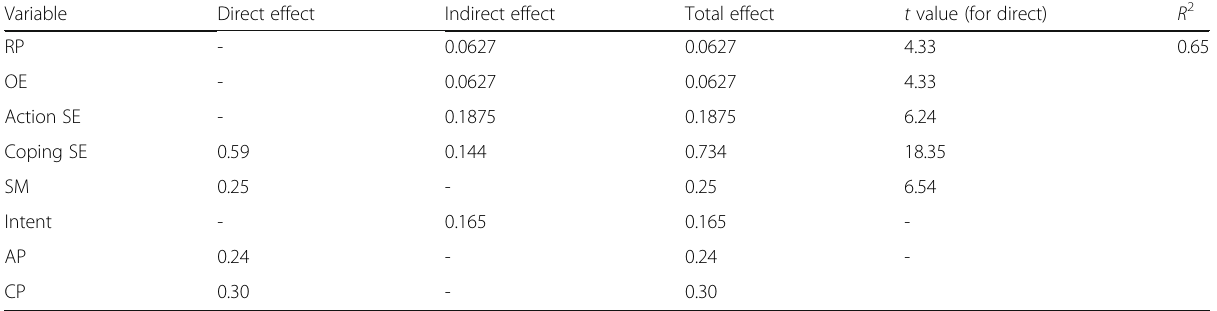
Table 4 Direct and indirect associations between HAPA variables and sunscreen use